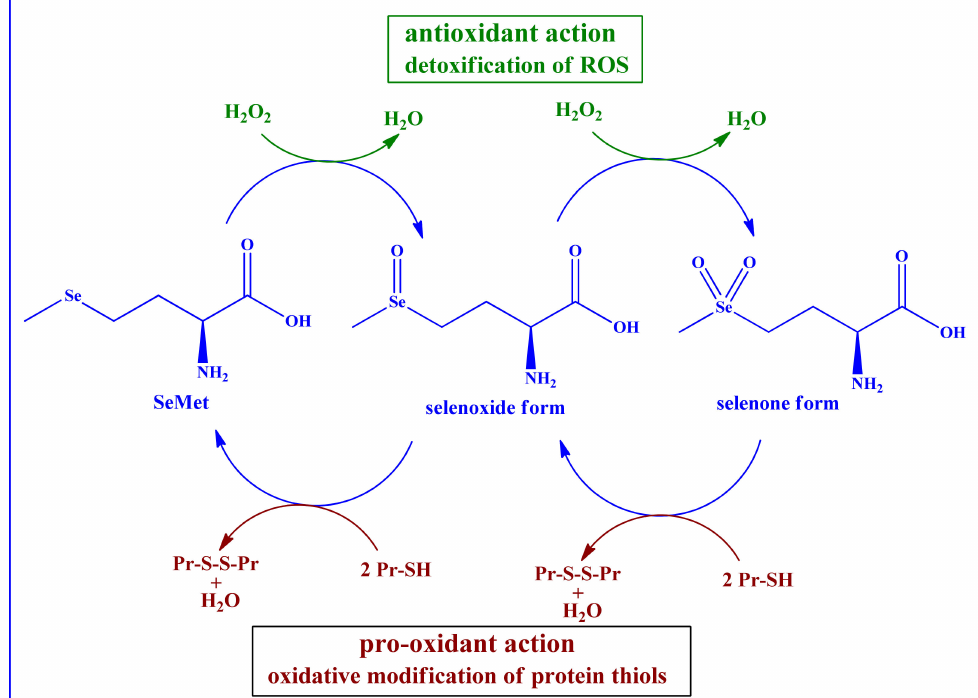
Figure 3. SeMet in its reduced and oxidized forms is redox active and able to engage in catalytic detoxification of ROS, such as H 2 O 2 . The resulting redox cycle consumes thiols and hence may change the cellular concentration of GSH and modulate the cellular thiolstat. Please also note that neither sulfur in Met nor selenium in SeMet are overoxidized under physiological conditions. Therefore, higher and quite interesting oxidation states, such as sulfones (RS(O) 2 R’) and selenones RSe(O) 2 R’) are less common and more an object for ex vivo hypothetical studies (Pr = protein)